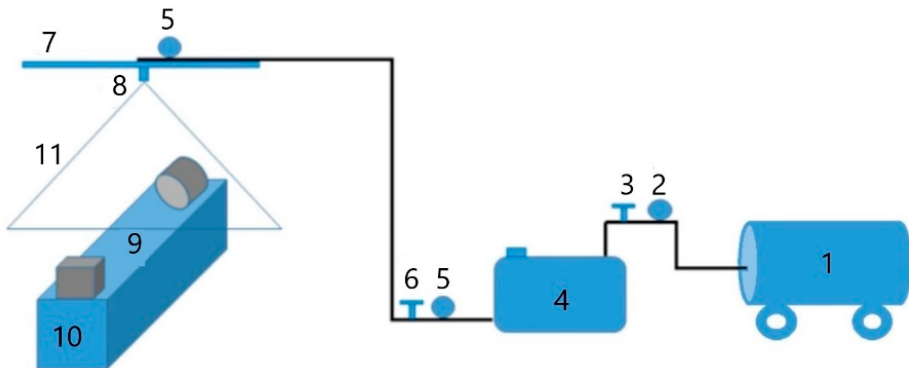
Figure 1. Components of the spraying system: 1—Air compressor, 2—Air pressure gauge, 3—Air pressure regulator, 4—Spray solution tank, 5—Spray pressure gauge, 6—Spray pressure regulator,